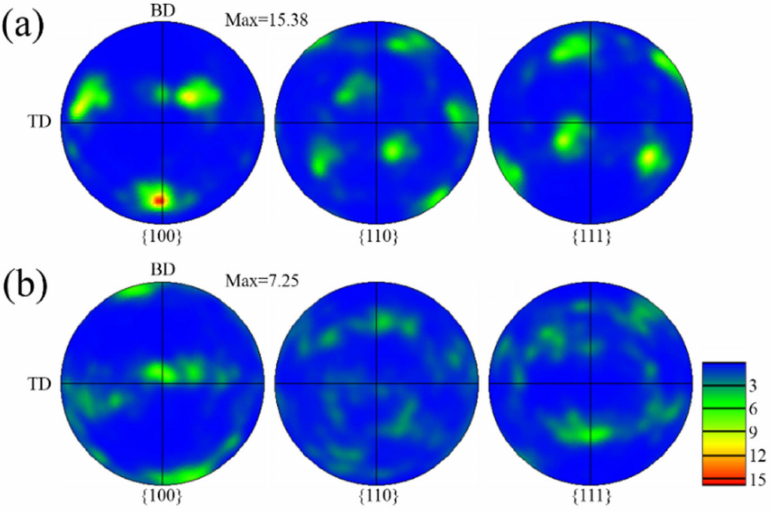
Figure 12. Pole figure with different track offset: ( a ) 1 mm; ( b ) 0.6